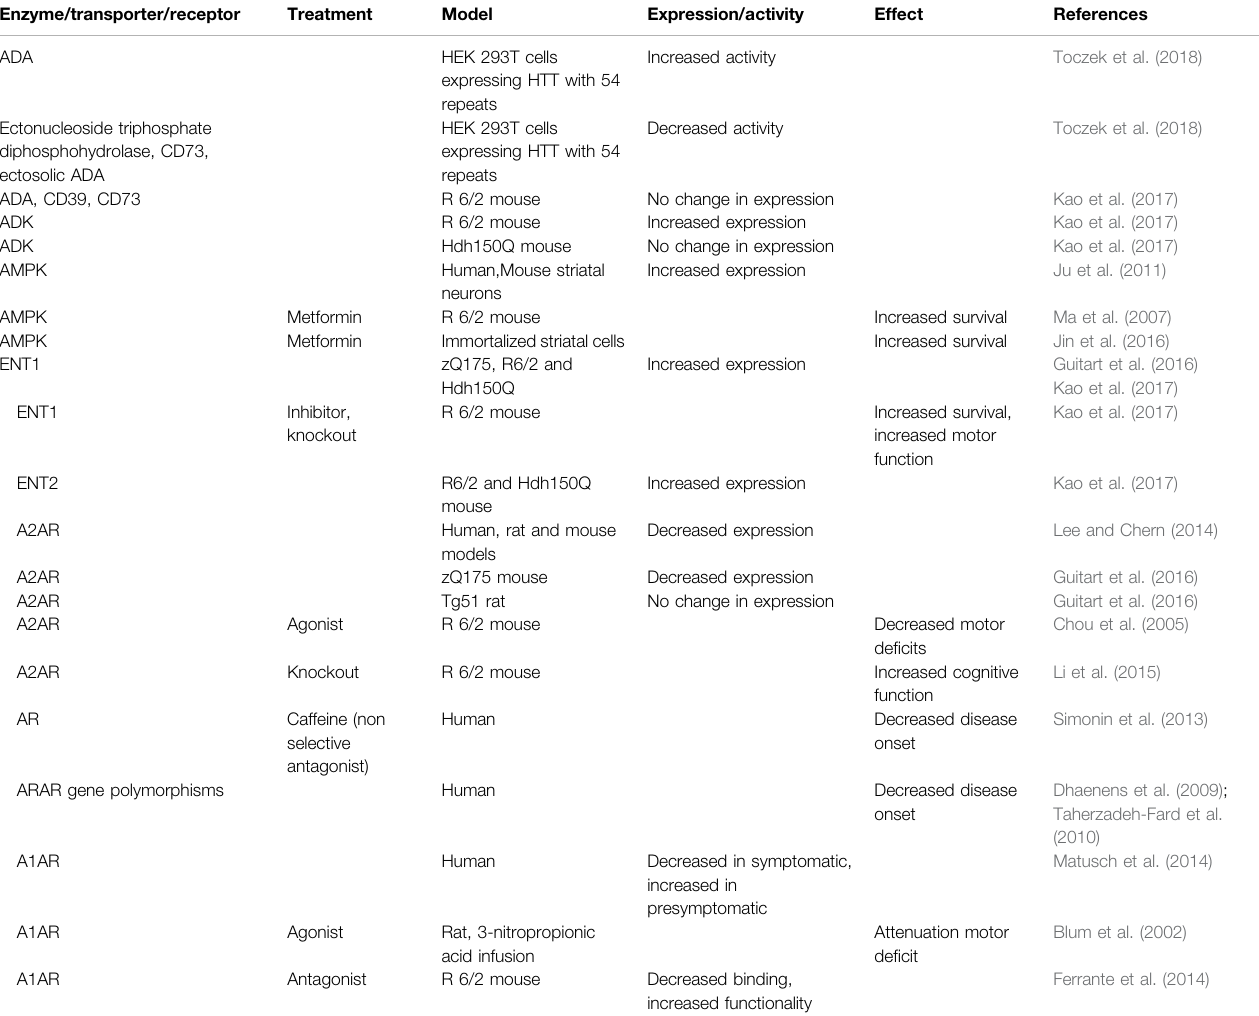
TABLE 1 | Involvement of adenosine metabolism enzymes, transporters and receptors in